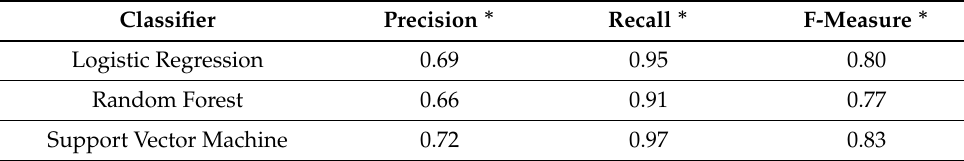
Table 3. Performance of the proposed framework using different